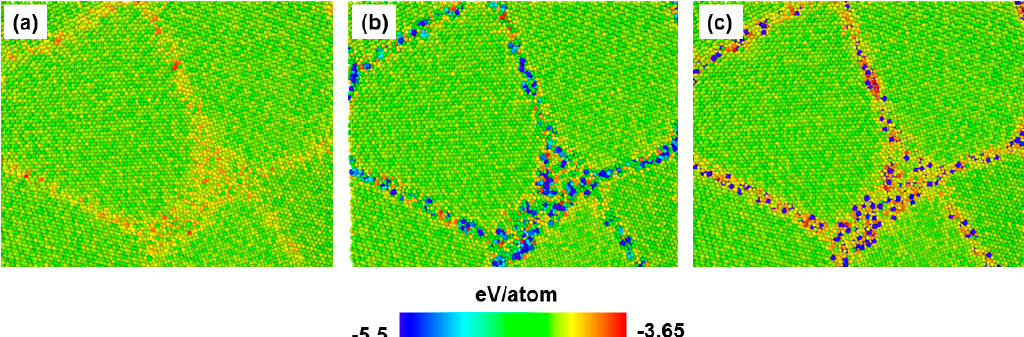
Figure 2. MD snapshot showing cross-sectional view of y-z plane of the potential energy per atom for annealed structures at 300 K. ( a ) Pure iron, ( b ) Fe-C, and ( c ) Fe-N. (For interpretation of the references to color in this figure, the reader is referred to the web version of this article).